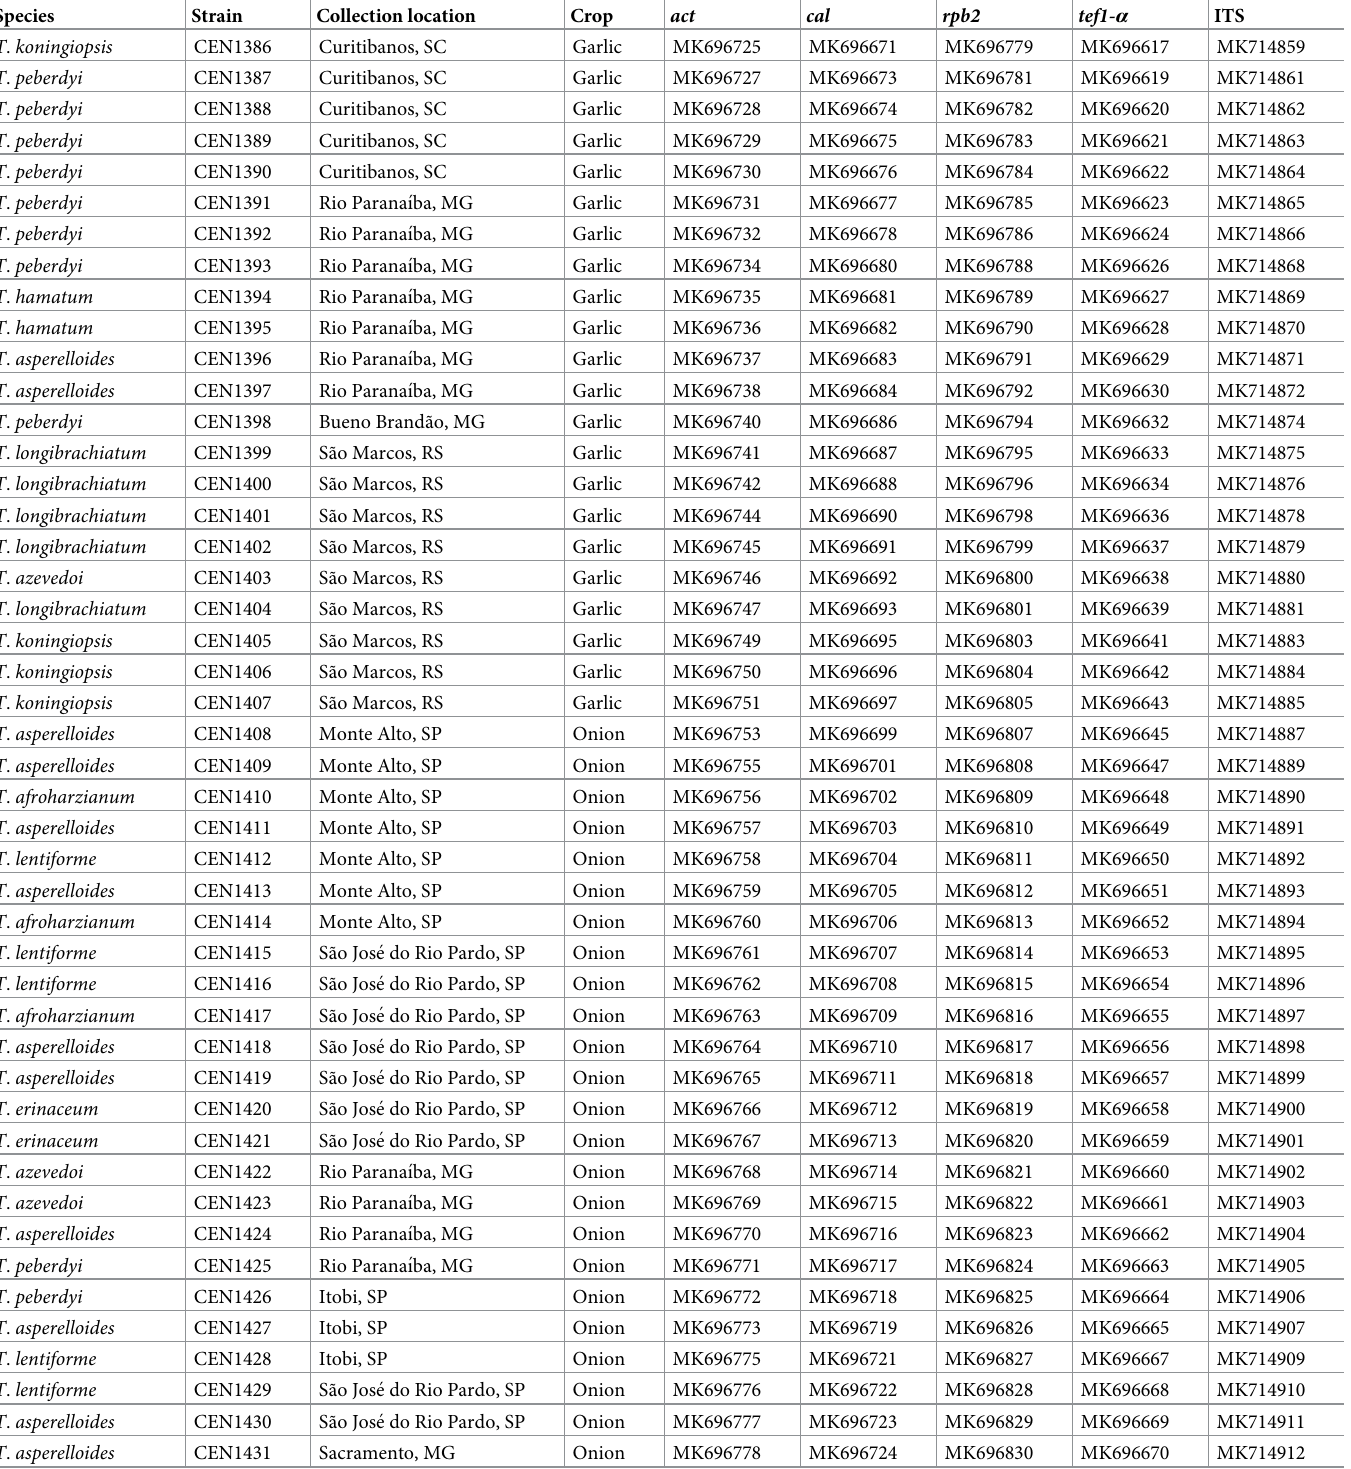
Table 1. Trichoderma species identified from garlic and onion crop soils in Brazil and Genbank accession numbers of their partial actin, calmodulin, rpb2 , tef1- α and ITS sequences used in phylogenetic analysis.